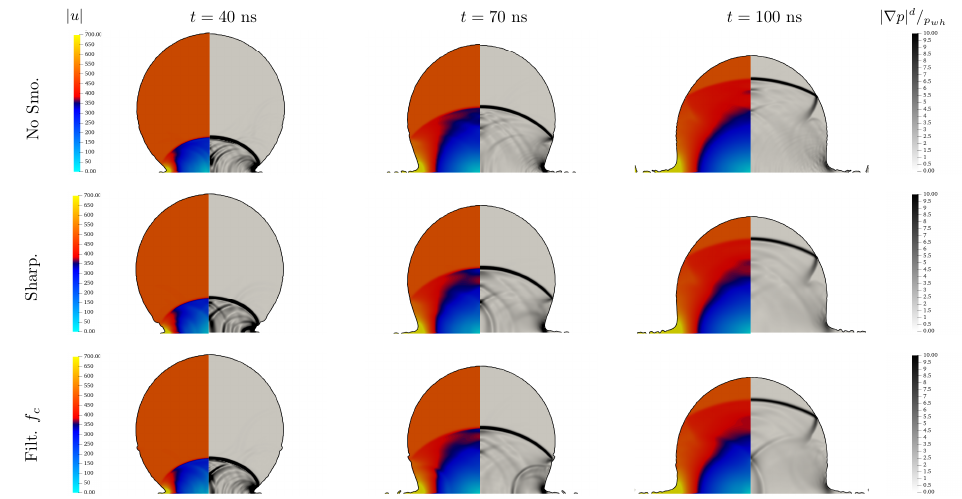
Figure 4. Velocity and pressure gradient distribution within the droplet for the different smoothing strategies cases at different instants. Black line represents the iso-line of α = 0.5.